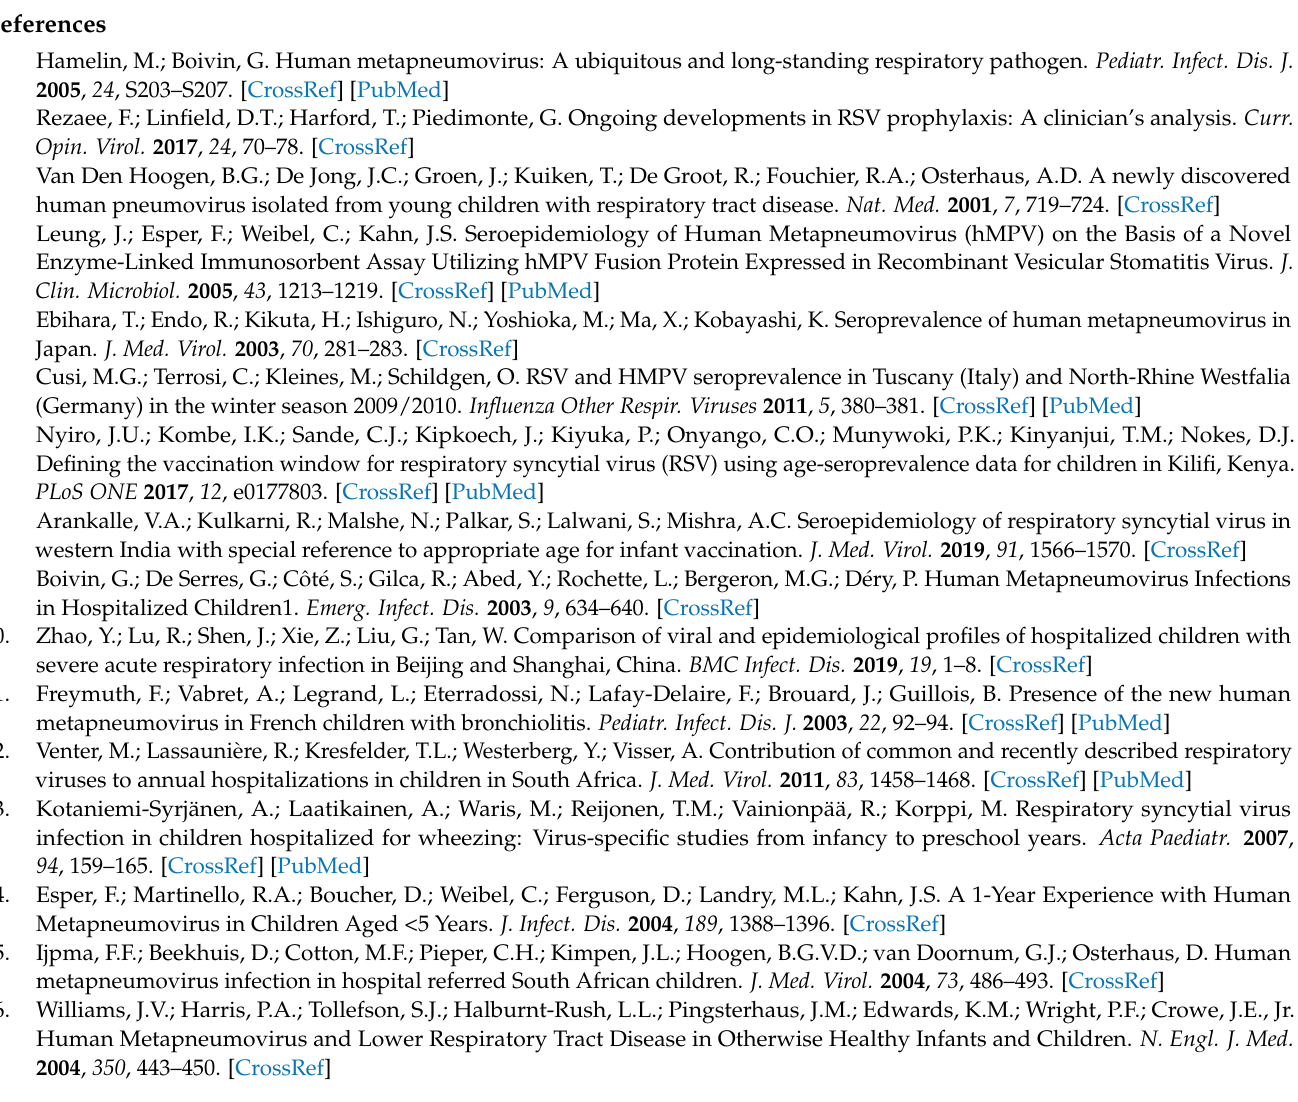
Figure S2: Schematic representation of HRSV and HMPV F